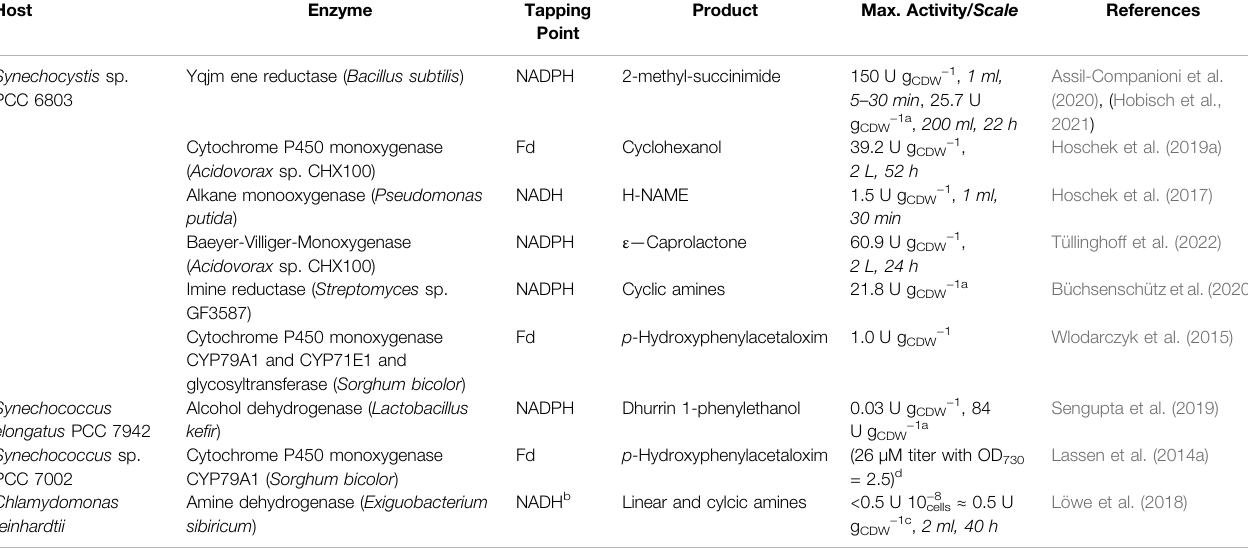
TABLE 2 | Recombinant redox biotransformations in cyanobacteria and microalgae. Adapted from Jodlbauer et al. (2021) und